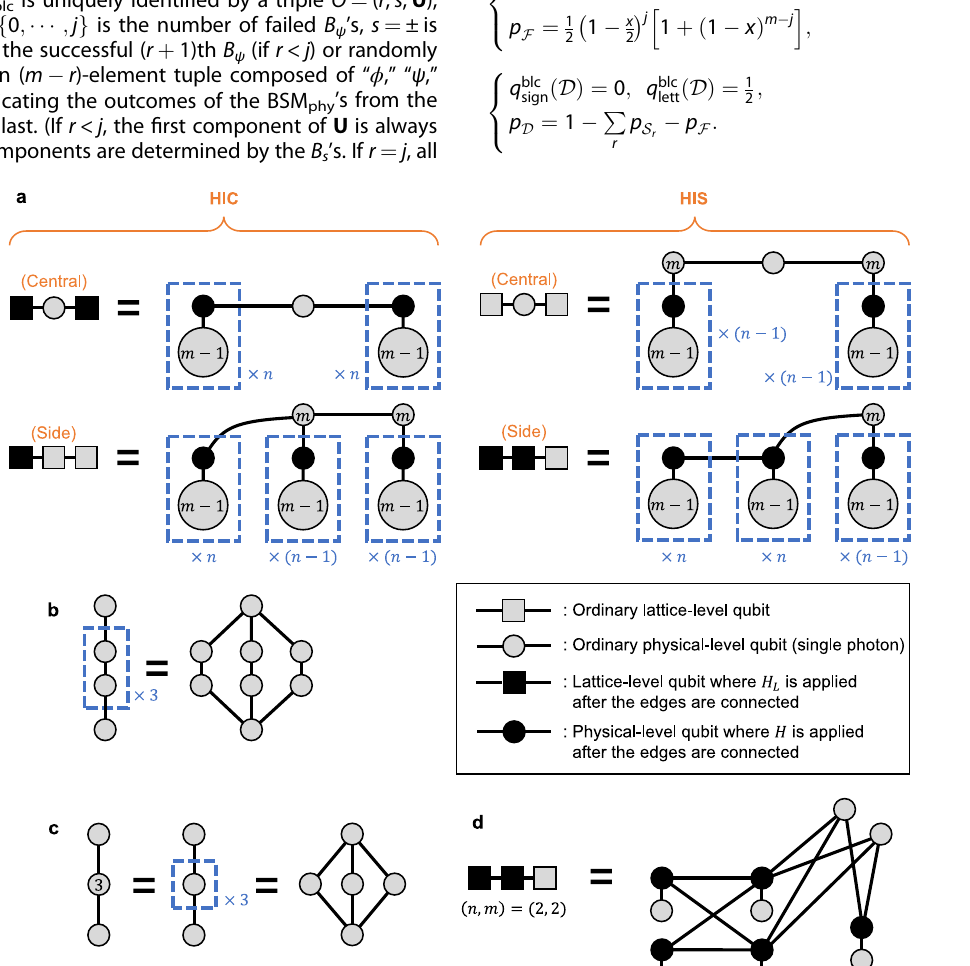
Fig. 8 Physical-level graphs of post- H microclusters for PTQC. In ( a ), the physical-level graphs of post- H microclusters for the HIC and HIS con fi gurations are shown for PTQC with the ( n , m ) parity encoding. The squares (circles) correspond to lattice-level (physical-level) qubits, among which black ones indicate that the lattice-level (physical-level) Hadamard gates are applied to the qubits on the graph state. A blue dashed box indicates a group of recurrent subgraphs; that is, the structure in the box is repeated as many times as indicated, and if there is an edge across the border of the box, it means that edges of the same pattern exist in each of the repeated structures. See ( b ) for an example. A number inside a circle means a blue dashed box surrounding only the circle with the indicated repetition number, as shown in the example of ( c ). If there is an edge between two blue dashed boxes or circles containing numbers, the full graph can be recovered just by expanding them one by one. As an example, the full graph of the side microcluster of the HIS con fi guration for n = m = 2 is shown in ( d